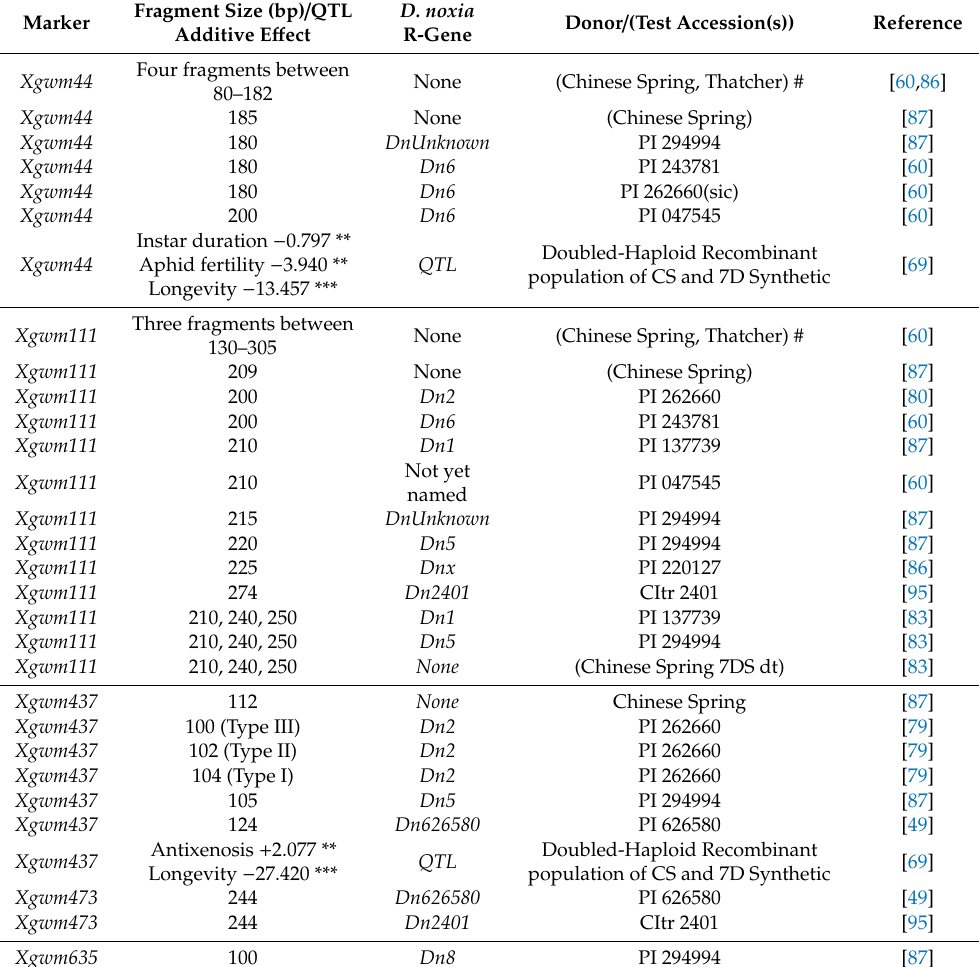
Table 1. Five D. noxia resistance-linked markers and reported fragment sizes / additive e ff ects for di ff erent Dn -genes / QTL from specific donor accessions on chromosome 7D of bread wheat. Fragment Size (bp) / QTL Marker Additive E ff